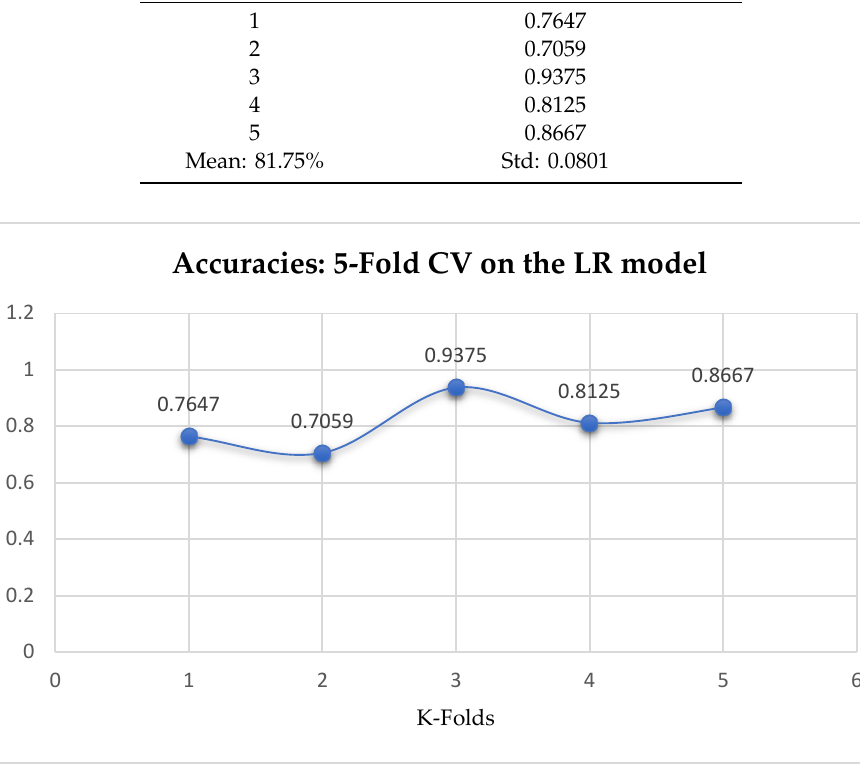
Figure 16. The accuracies achieved by the Folds after performing 10-Fold Cross-Validation on the LR model.